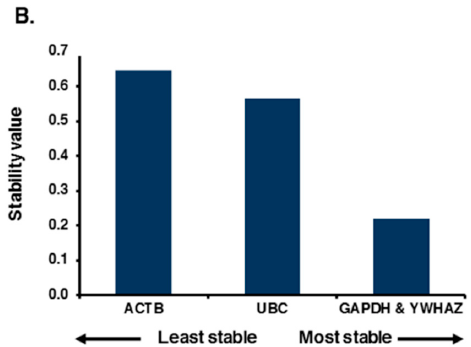
Figure 3. Expression stability analysis for the final four candidate reference genes in phase II. Expression of each candidate gene was examined in a total of 18 saliva samples (nine with childhood Autism and nine healthy controls) ranked compared with the rest by ( A ) geNorm and ( B ) NormFinder algorithms